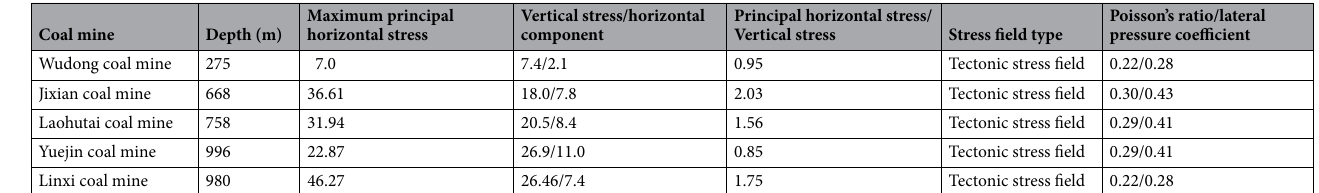
Table 2. Relationship between the measured maximum horizontal principal stress and vertical stress components in some Chinese coal mines.